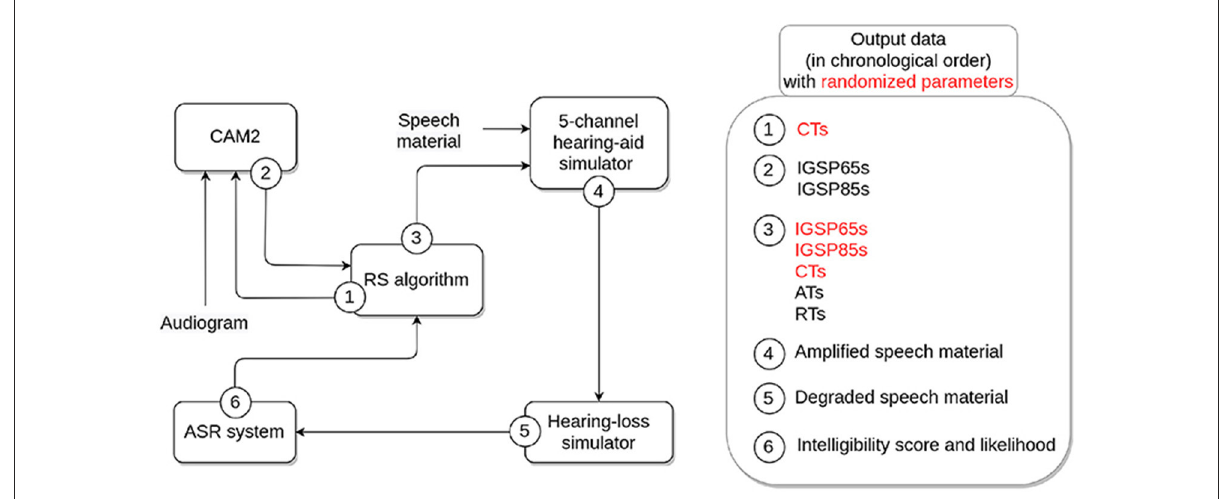
FIGURE1 Overview of the components of the OPRA-RS processing chain and associated output data. HA parameters randomized by the RS algorithm appear in